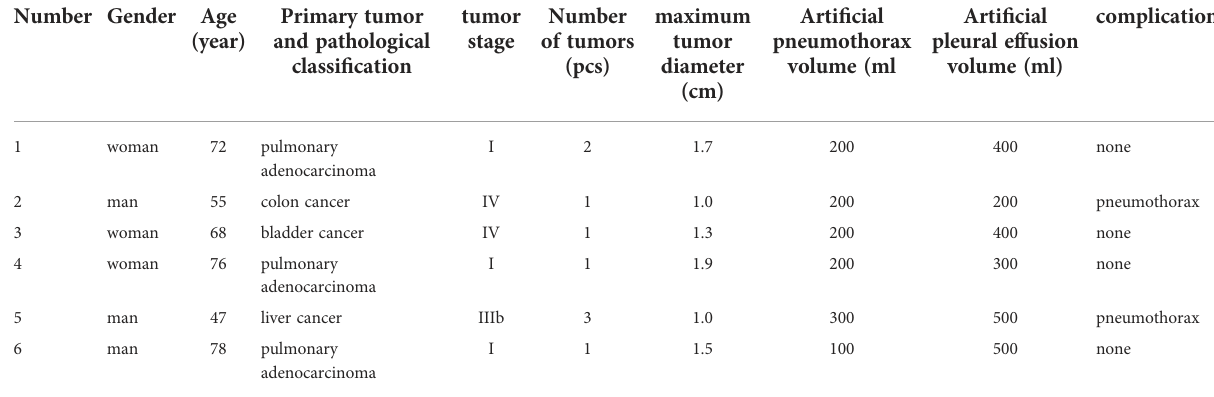
TABLE 1 Clinical data of 6 patients with lung cancer and the results of microwave ablation therapy assisted by arti fi cial pneumothorax and arti fi cial hydrothorax. Number Gender Age